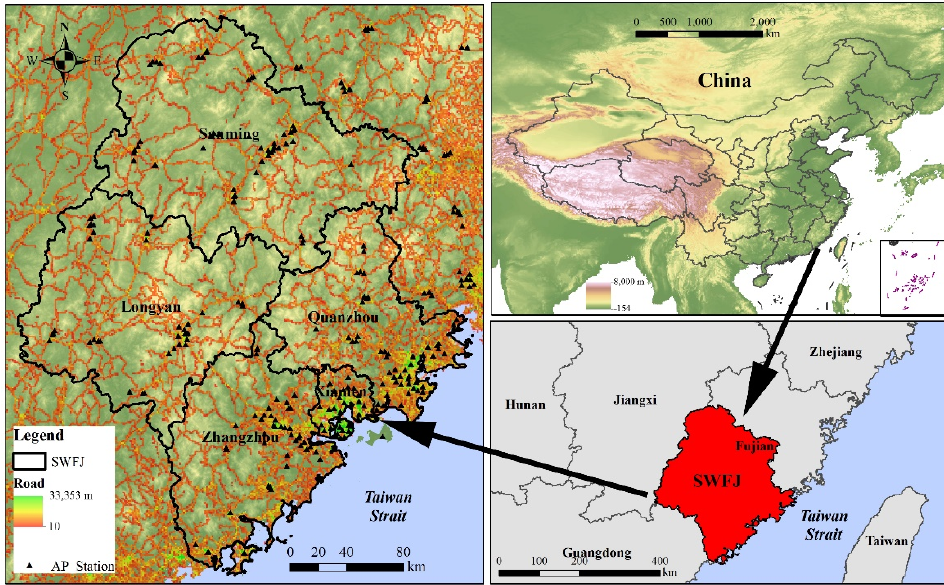
Figure 1. Study area, including SWFJ. The black dots represent the location of the ground NO 2 - monitoring station. AP station represents the spatial location of the air-pollutant-monitoring station, and Road represents the total length of the road in independent pixels, ranging from 10 m to 33353 m. Orange pixels represent shorter total road lengths, and green pixels represent longer total road